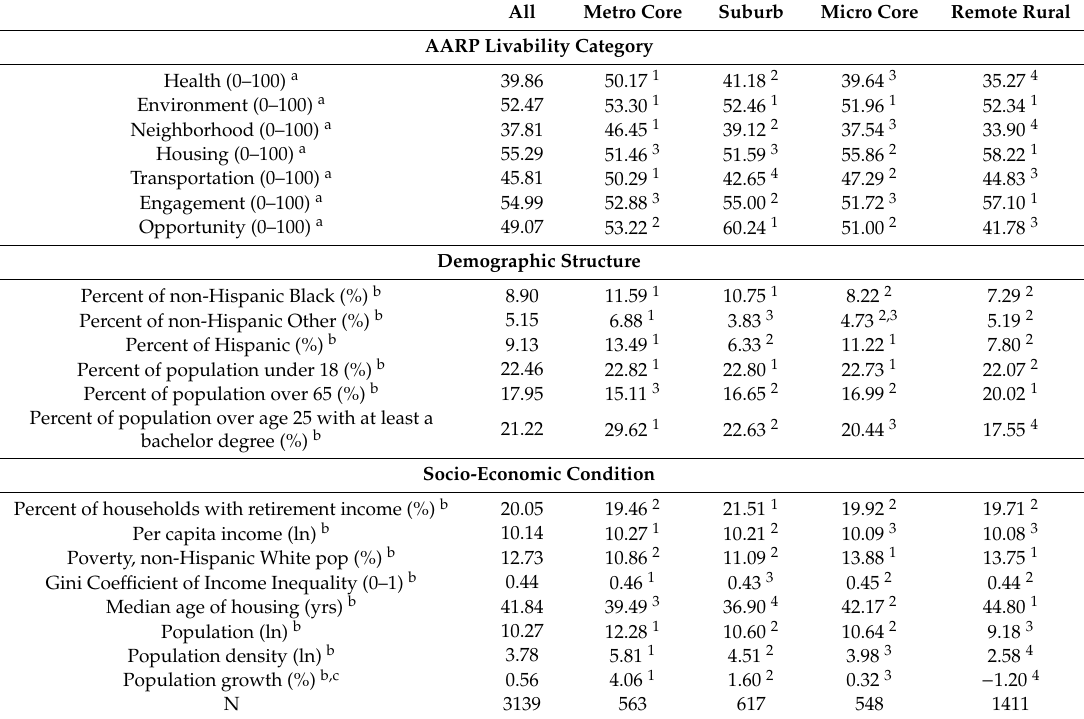
Table 1. Descriptive statistics, US counties (mean).